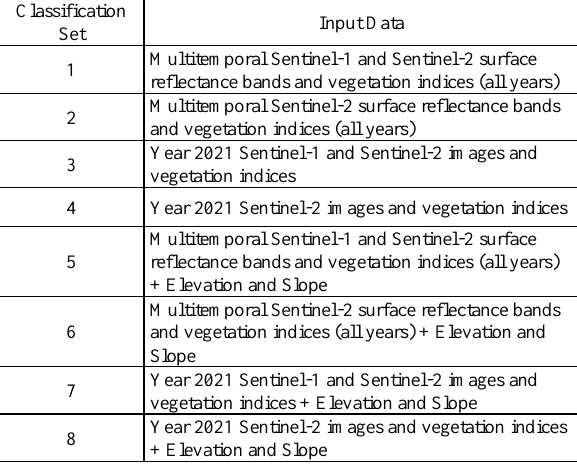
Table 2 . The different sets of input data for SVM and RF classifications.